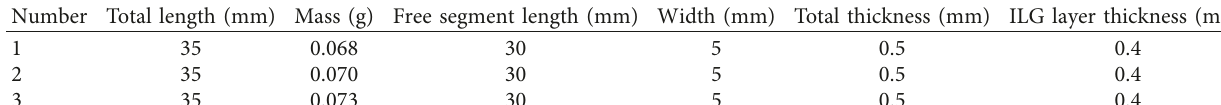
Table 3: Parameters of the soft manipulator.